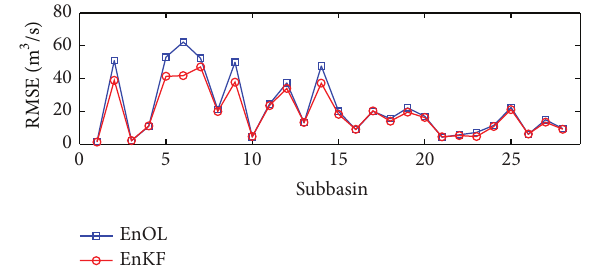
Figure 10: The RMSE (15) of the estimated streamflow obtained by EnOL and EnKF at the subbasin outlet in the assimilation of the streamflow observations at the catchment